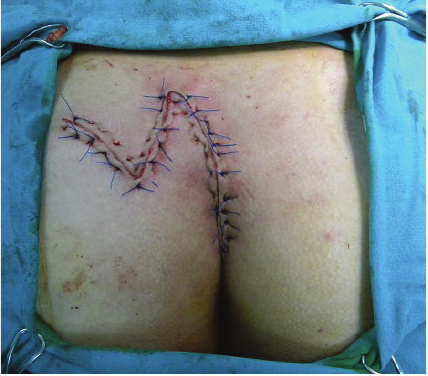
Figure 3: Appearance after flap